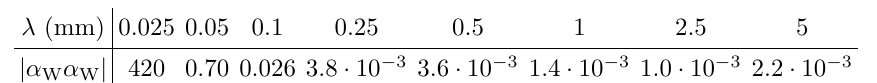
Table 8 . 95% C.L. constraints on the combinations | α W α W | as a function of λ = 1 /m a set by the HUST experiment